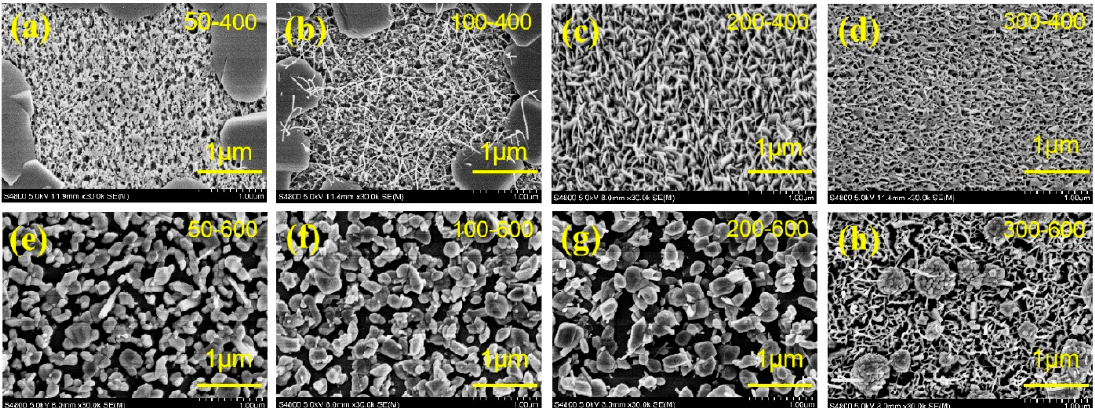
Figure 2. SEM surface morphology of the MoS 2 films at different deposition–annealing temperatures: ( a ) 50–400 ◦ C, ( b ) 100–400 ◦ C, ( c ) 200–400 ◦ C, ( d ) 300–400 ◦ C, ( e ) 50–600 ◦ C, ( f )100–600 ◦ C, ( g ) 200–600 ◦